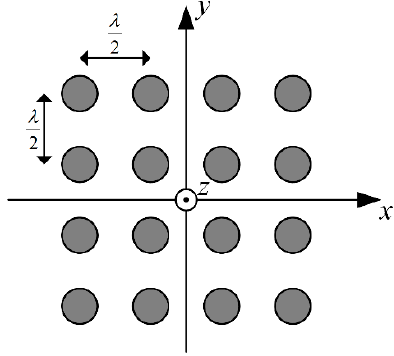
Figure 4. Arrangement of sensors in simulated model of antenna array.